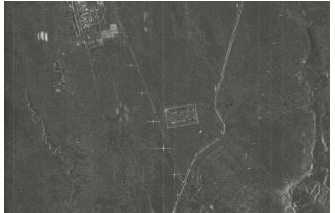
SAR image of the CRs is shown in Figure 17. The image quality metrics, such as spatial resolution, peak side lobe ratio (PSLR), integrated side lobe ratio (ISLR), are calculated based on the impulse response function of point targets (CRs).